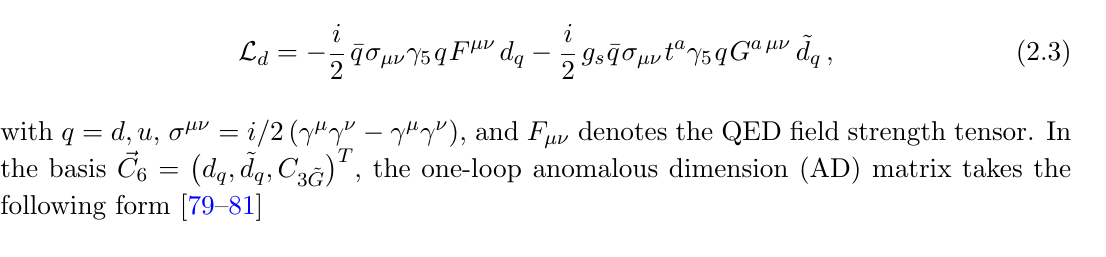
arising from the insertion of C 3 ~ G . The operator insertions (cid:30) ~ G